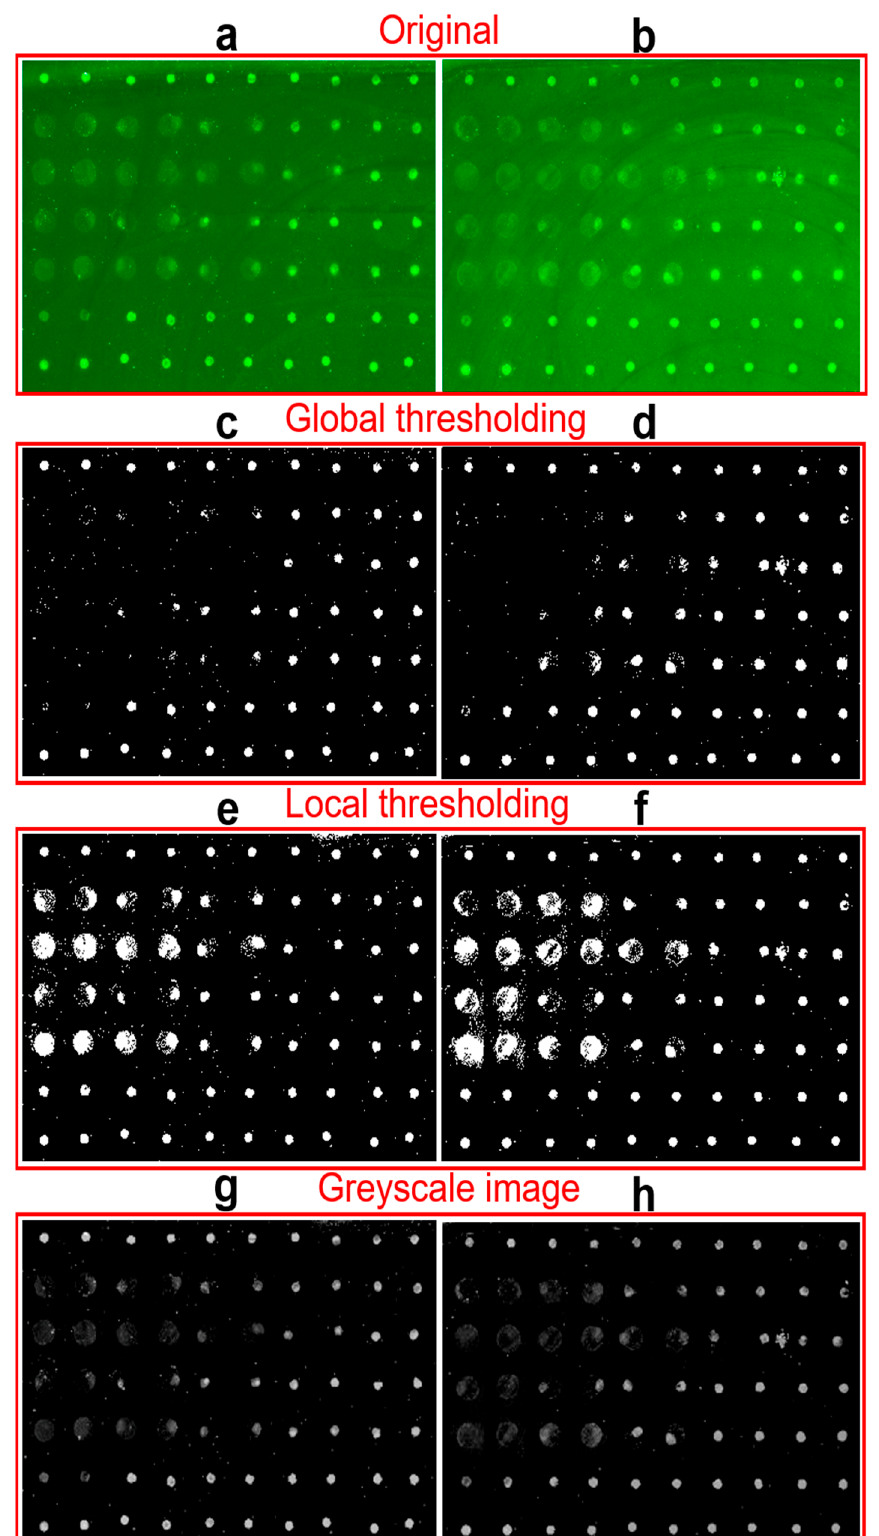
Figure 4. Comparison of global thresholding and local thresholding. ( a , b ) The original fluorescent images of two experimental spots matrix. ( c , d ) The corresponding binary images of images ( a , b ) after global thresholding processing. ( e , f ) The binary images of images ( a , b ) after local thresholding processing. ( g , h ) The corresponding greyscale images of ( a , b ) after subtracting local background.